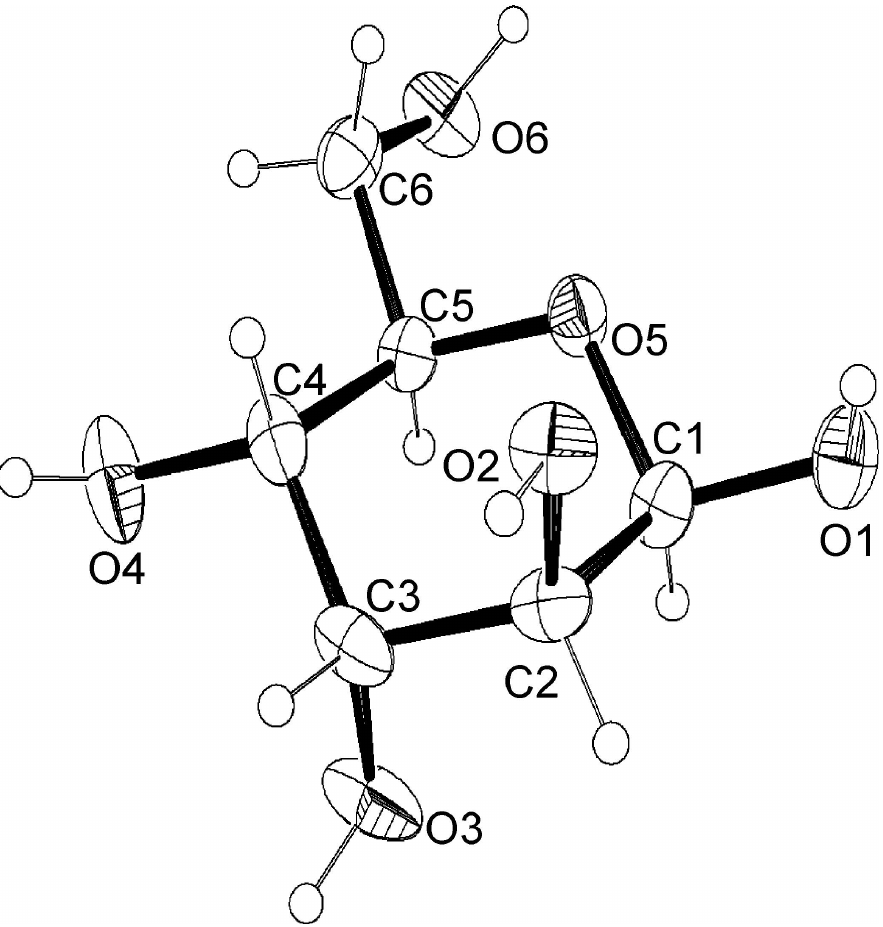
Figure 1 A view of the molecule of β -D-altrose, showing the atom-labelling scheme. Displacement ellipsoids are drawn at the 50% probability